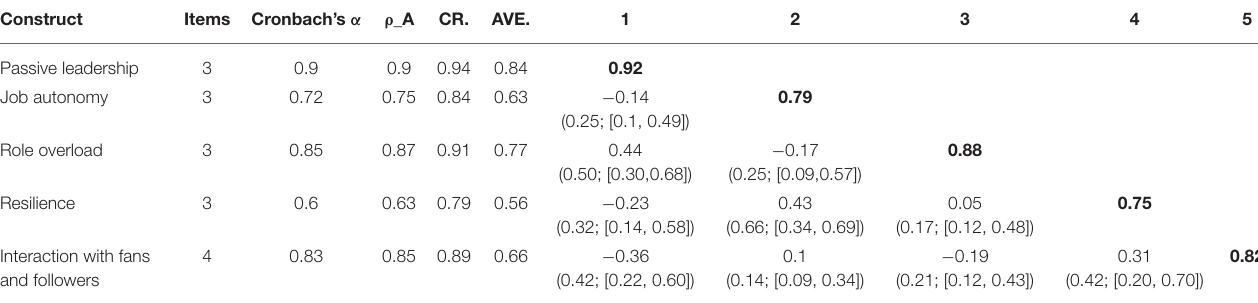
TABLE 2 | Inter-construct correlations, reliability measures, and HTMT ( N = 122). Construct Items Cronbach’s α ρ _A CR.